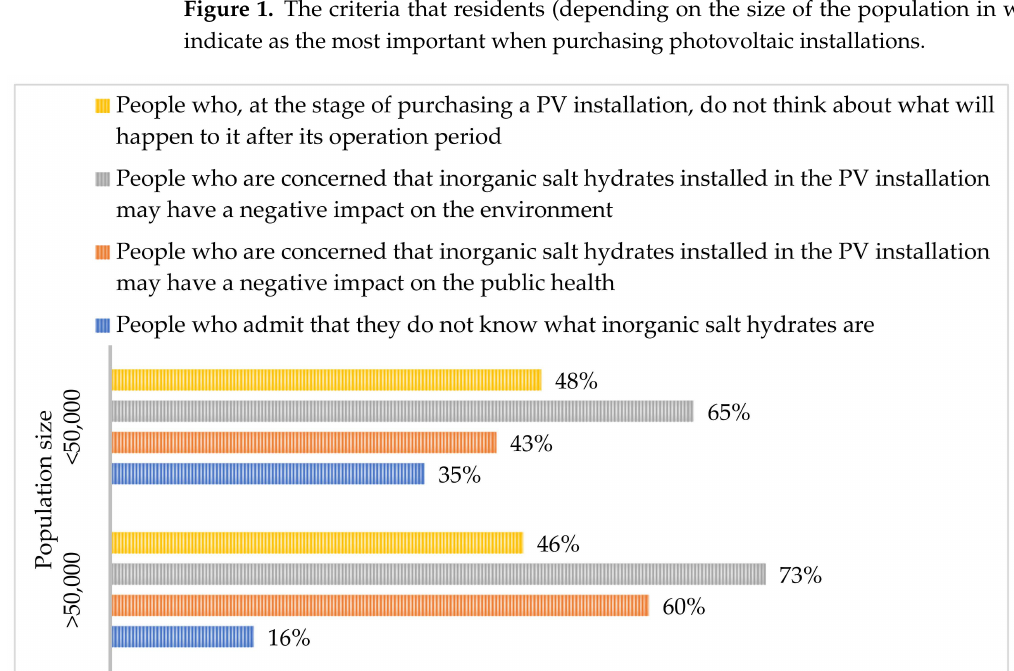
Figure 2. The approach of the society (depending on the size of the population in which they live) to a PV installation with a converter containing inorganic salt